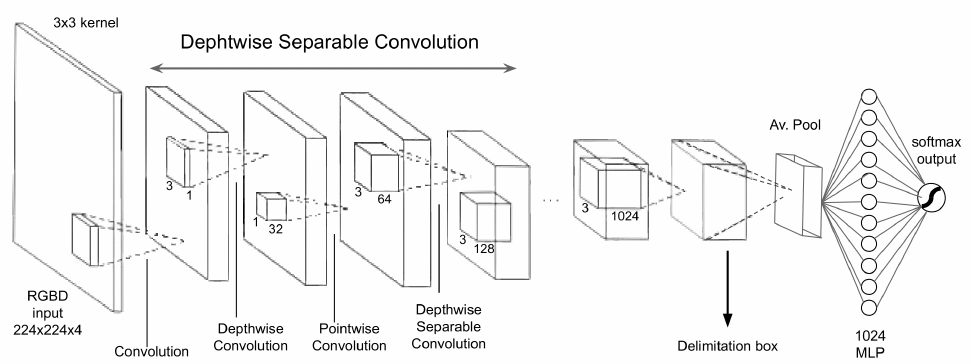
Figure 4. Mobilenet model for object detection